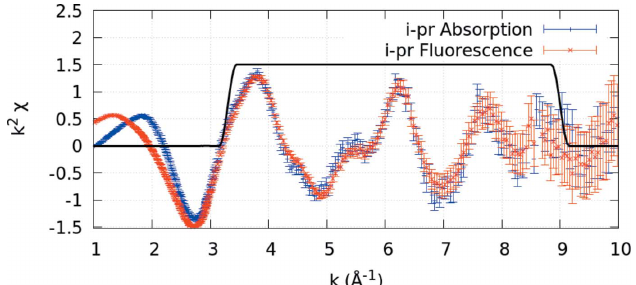
Figure 12 Transmission versus fluorescence spectra. An excellent agreement is found between the two spectra within the Hanning window, indicative of the success of our self-absorption correction methodology. Some discrepancies remain between the two spectra, particularly in the application of background subtraction, edge removal and spline removal, an observation made possible by our propagation of statistically robust experimental uncertainties. A subsequent publication will present this in detail and contrast the results of structural modelling of these two data